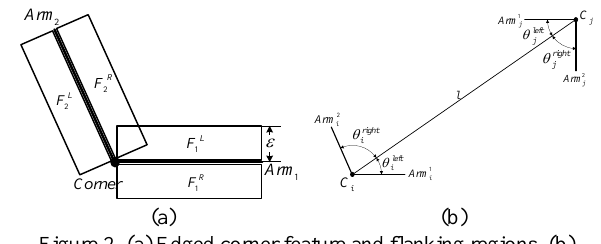
Figure 2. (a) Edged corner feature and flanking regions, (b) context feature